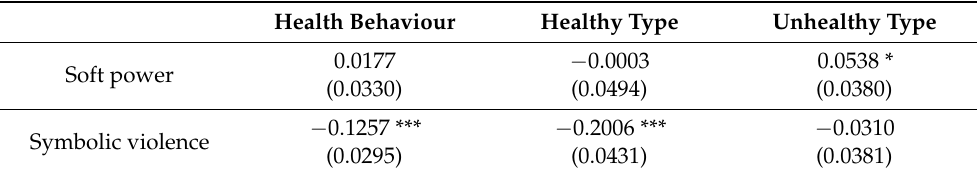
Table 5. The impact of soft power and symbolic violence on health behaviour score in the last and third intervention